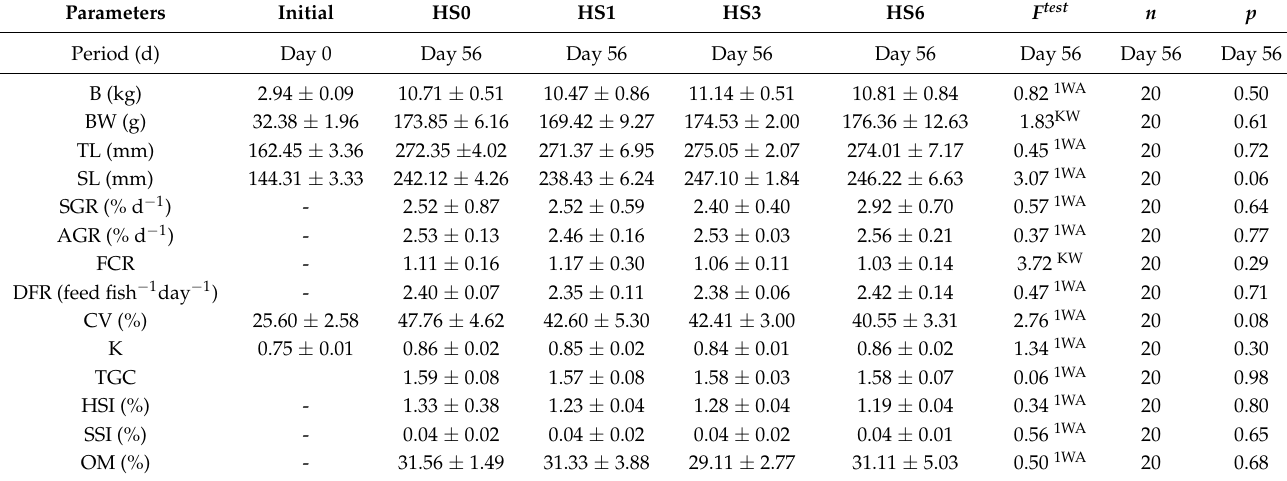
Values are presented as mean ± SD. Number of considered experimental units ( n ). One-way ANOVA ( 1WA ) or Kruskal-Wallis ( KW ) test results are power of test ( F ), and level of significance ( p ). Different superscripts (a, b) indicate significant differences (Tukey HSD test, p < 0.05) within one